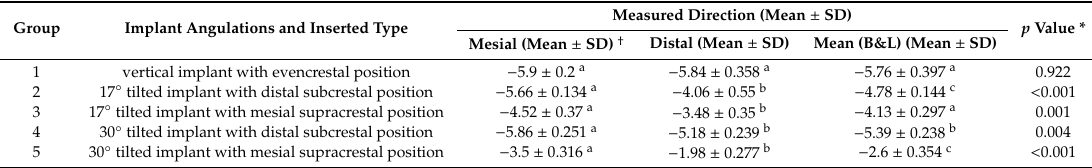
Table 2. PTV in the five